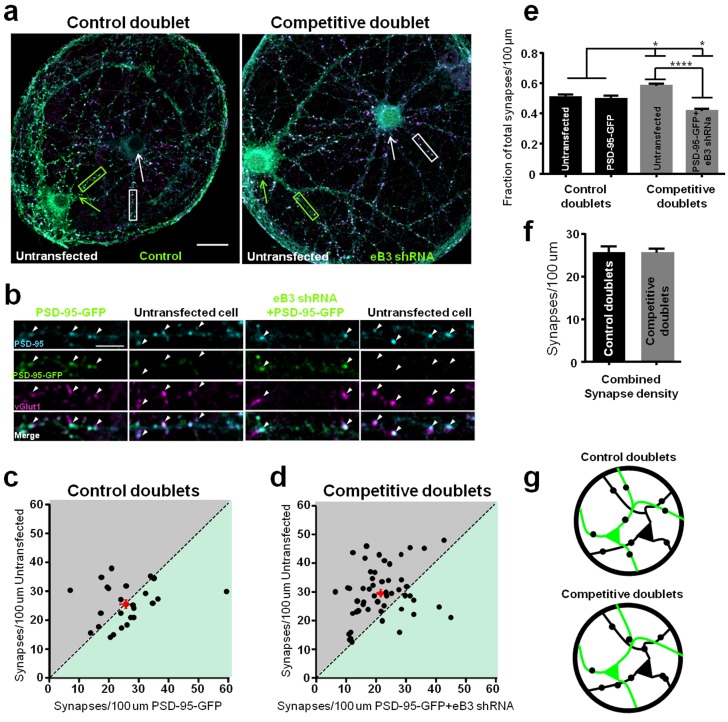
Synapse density is regulated by an ephrin-B3-dependent competitive mechanism.(a) Representative images of control and competitive doublets. Neurons were immunostained for vGlut1, PSD-95 and GFP (for PSD-95-GFP) at DIV21. Arrows indicate untransfected (white arrow) and transfected (green arrow) neurons. Scale bar, 20 μm. (b) Higher magnification images of the boxed regions shown in a. Arrowheads indicate examples of colocalized puncta. Scale bar, 5 μm. (c and d) Scatter plots in which the x and y coordinates of each point respectively represent synapse density in transfected and untransfected neurons within a doublet pair. The red point in each graph represents the average of all data points. (e) Quantification of the fraction of total synapse density on neurons within control and competitive doublets (control doublets, n=25 for untransfected and PSD-95-GFP cells; competitive doublets, n=53 for untransfected and eB3 shRNA cells; F(3,152)=23.12, p<0.0001, one-way ANOVA *P<0.05,****P<0.0001 Tukey’s post hoc. (f) Quantification of total synapse density in doublets (control doublets, n=25; competitive doublets n=53; t(76)=.01448, p=0.9882, two-tailed Student’s t-test). (g) Schematic of the microisland doublet experiment. Black and green neurons indicate untransfected and transfected neurons, respectively. Synapses are represented as black dots.10.7554/eLife.41563.008Figure 3—source data 1.Synapse density is regulated by a competitive mechanism.